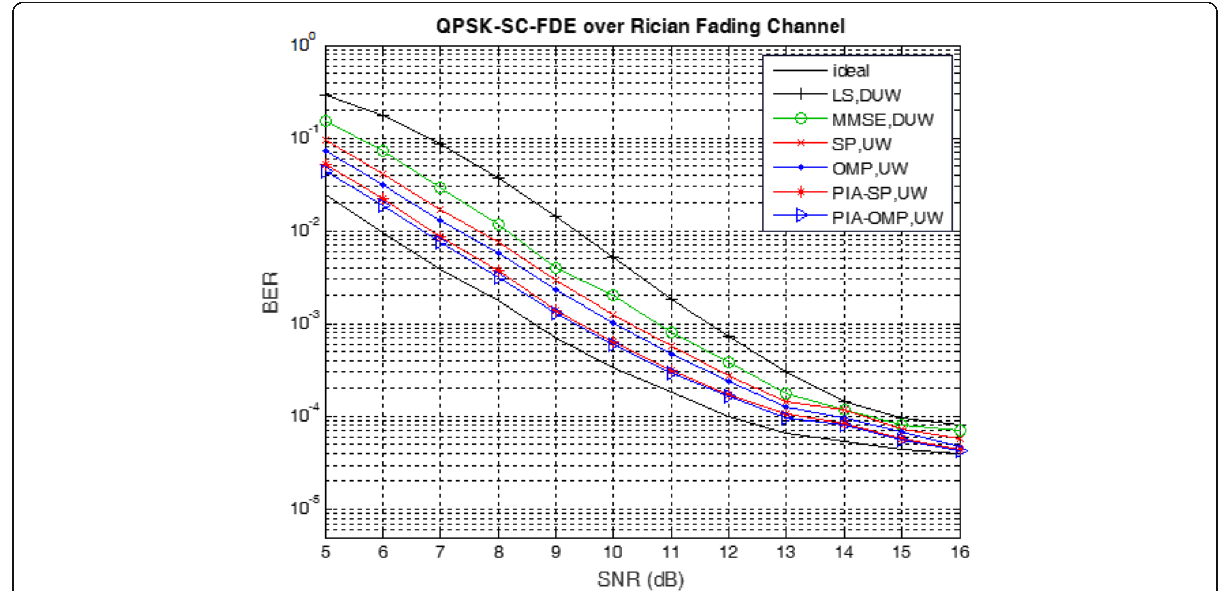
Fig. 5 The BER performance comparison between the proposed channel estimation scheme and its conventional counterparts with P =